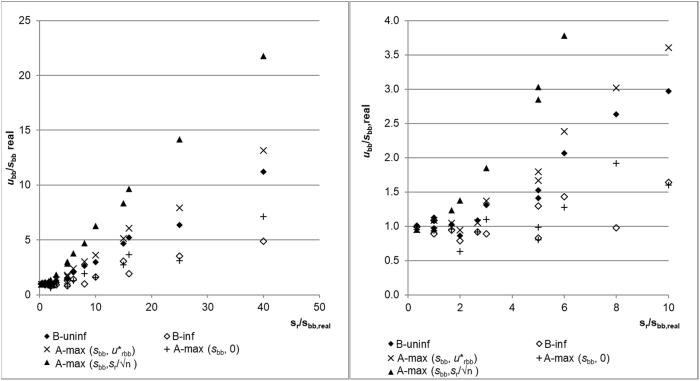
Average estimation. Left all sr/sbb,real ratios. Right: only area for sr/sbb,real up to 10.